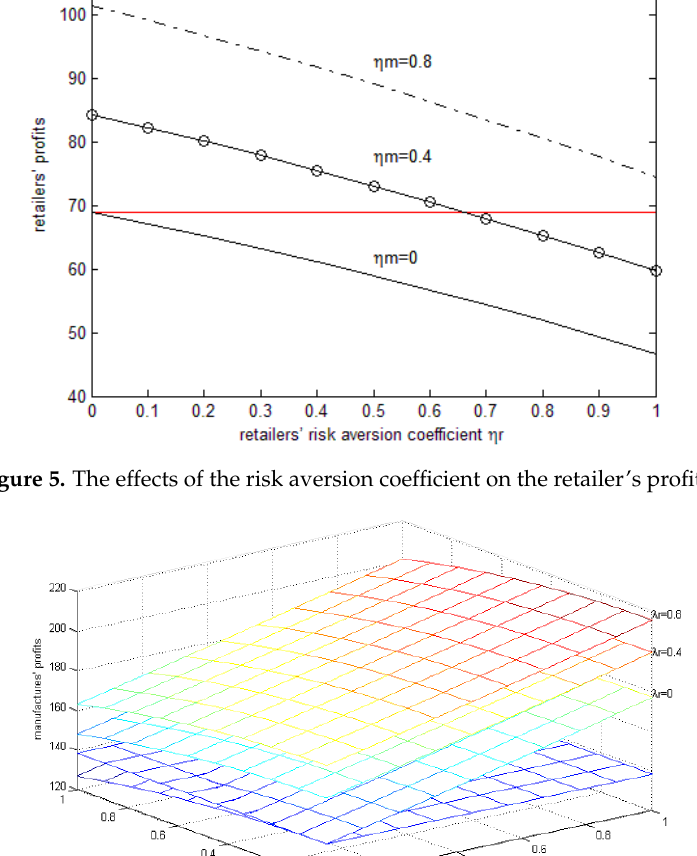
Figure 5. The effects of the risk aversion coefficient on the retailer’s profits.